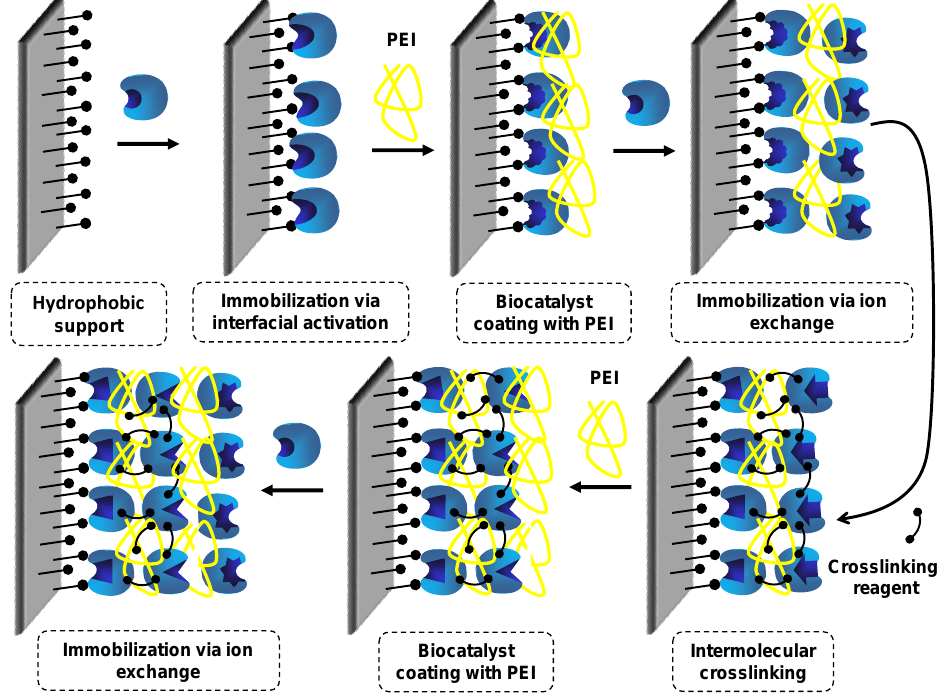
Figure 27. Preparations of a multilayer biocatalyst with the same enzyme employing PEI and glutaraldehyde as glue. The result is a combilipase bearing three lipase forms. This enzyme layer by enzyme layer strategy, when immobilizing different enzymes, permitted to control the spatial distribution of the different enzymes, until five different lipases were immobilized using different spatial distribution, with very different impact on the final biocatalysts activity versus different substrates [458] (Figure 28).